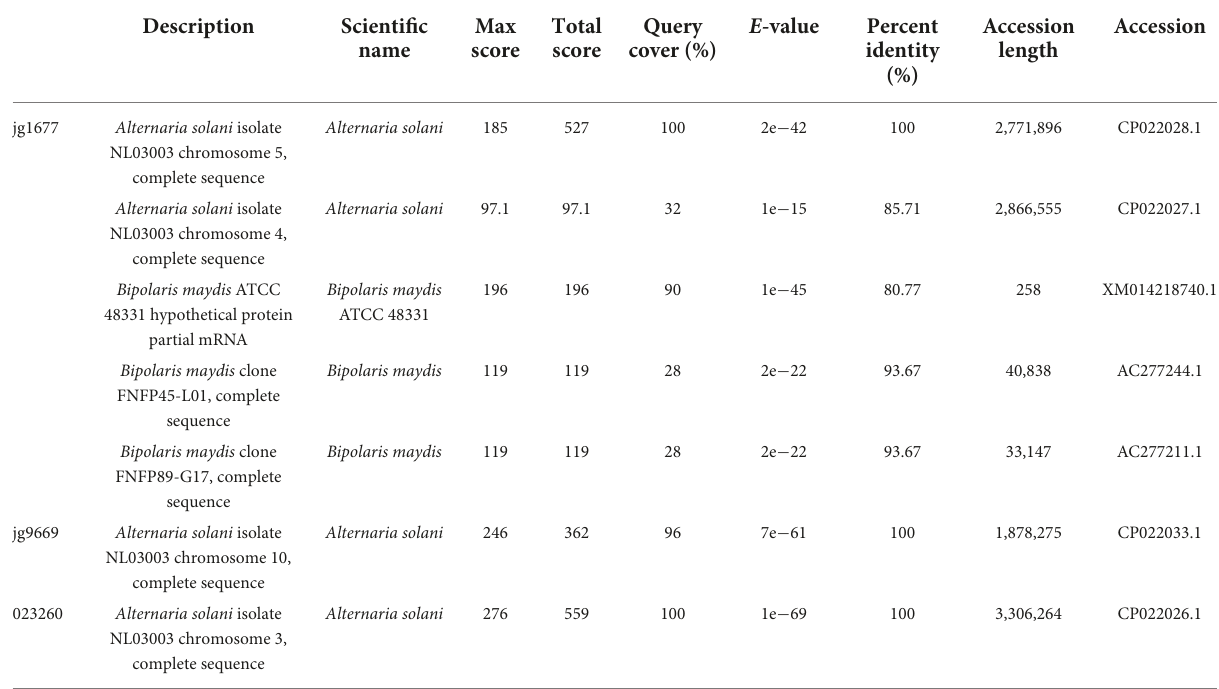
TABLE 1 Sequences producing significant